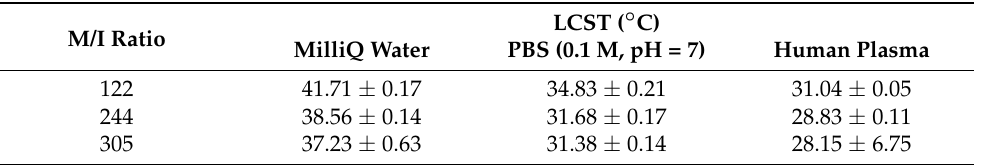
Figure 6. ( a ) Variation of UV-VIS spectrum of a solution of PNVCL_244 in human plasma (0.5 wt.%) with temperature. ( b ) Transmittance of PNVCL_122 (black squares), PNVCL_244 (blue circles) and PNVCL_305 (red triangles) solution in human plasma (0.5 wt.%) calculated at 800 nm reported as a function of temperature. The graph also shows the sigmoidal fitting functions that were used for the calculations of the LCST. Table 2. Comparison between the LCST of PNVCL-COOH polymers (0.5 wt. %) in milliQ water and in human